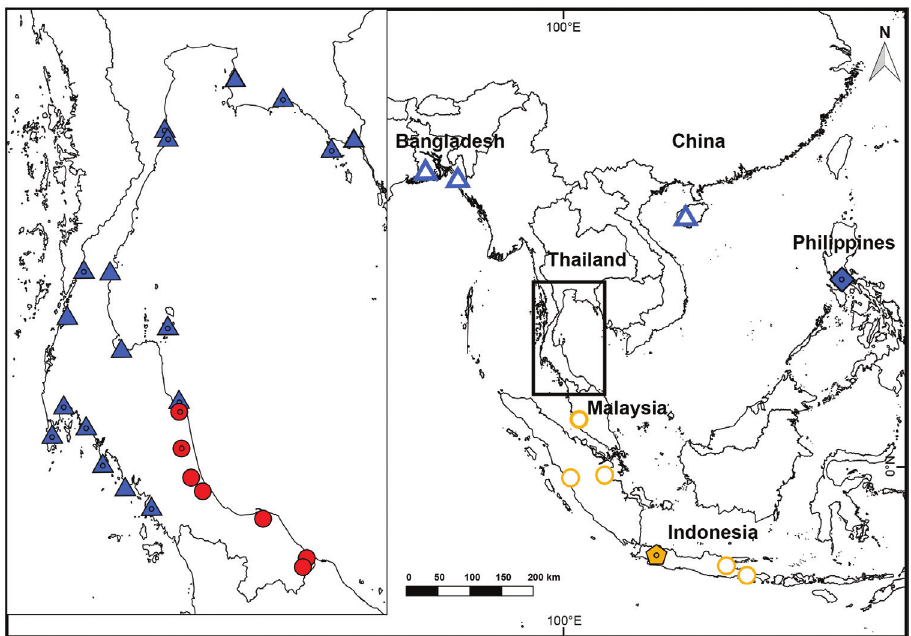
Figure 1. Map of sampling localities of the Fejervarya cancrivora complex, including F. cancrivora neo- type (yellow pentagon), F. cancrivora sensu stricto (yellow circles), F. moodiei holotype (blue diamond), F. moodiei (blue triangles), and F. cancrivora samples that were referred to F. raja (red circles) prior to this study. Open symbols indicate molecular data only, shaded symbols indicate morphological data only, and shaded symbols with center dots indicate both molecular and morphological data were